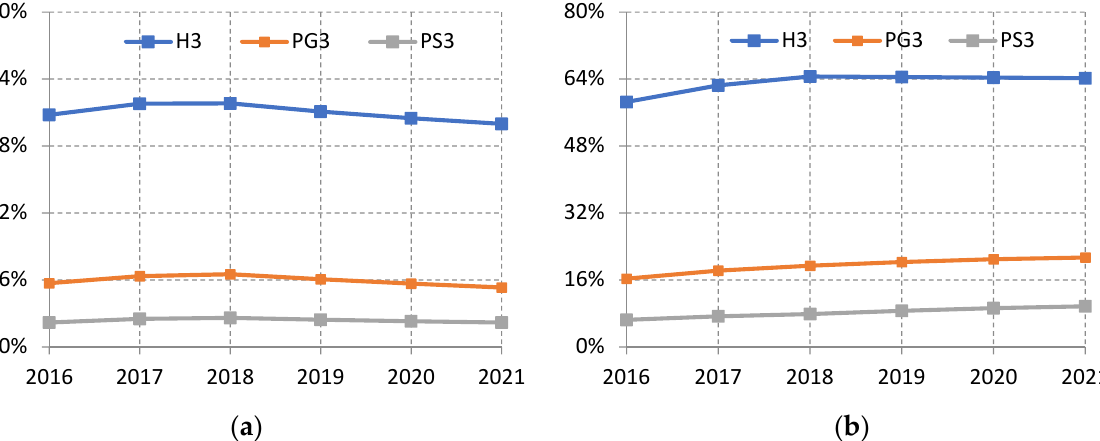
Figure 4. Intertemporal calculations of consumption poverty: ( a ) rural resettled; ( b ) urban reset- tled.